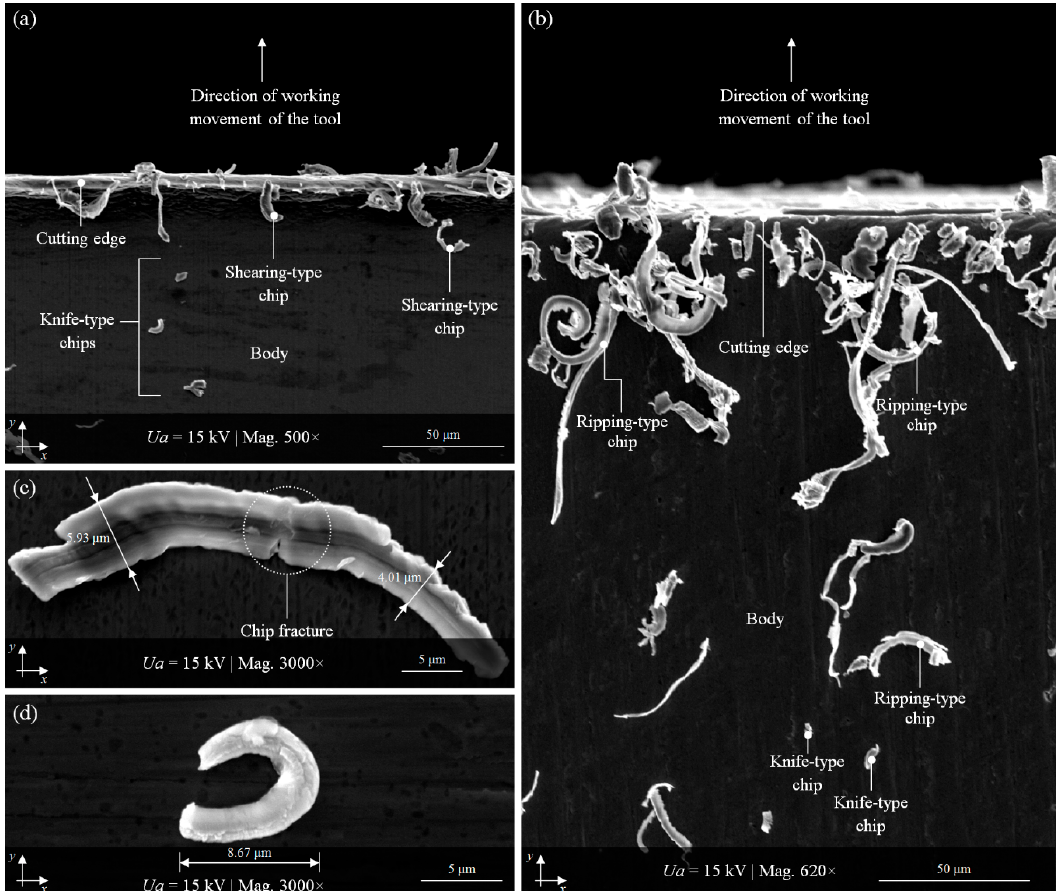
Figure 8. Selected results of SEM imaging (JEOL JSM-5500LV) of planar cutting blade